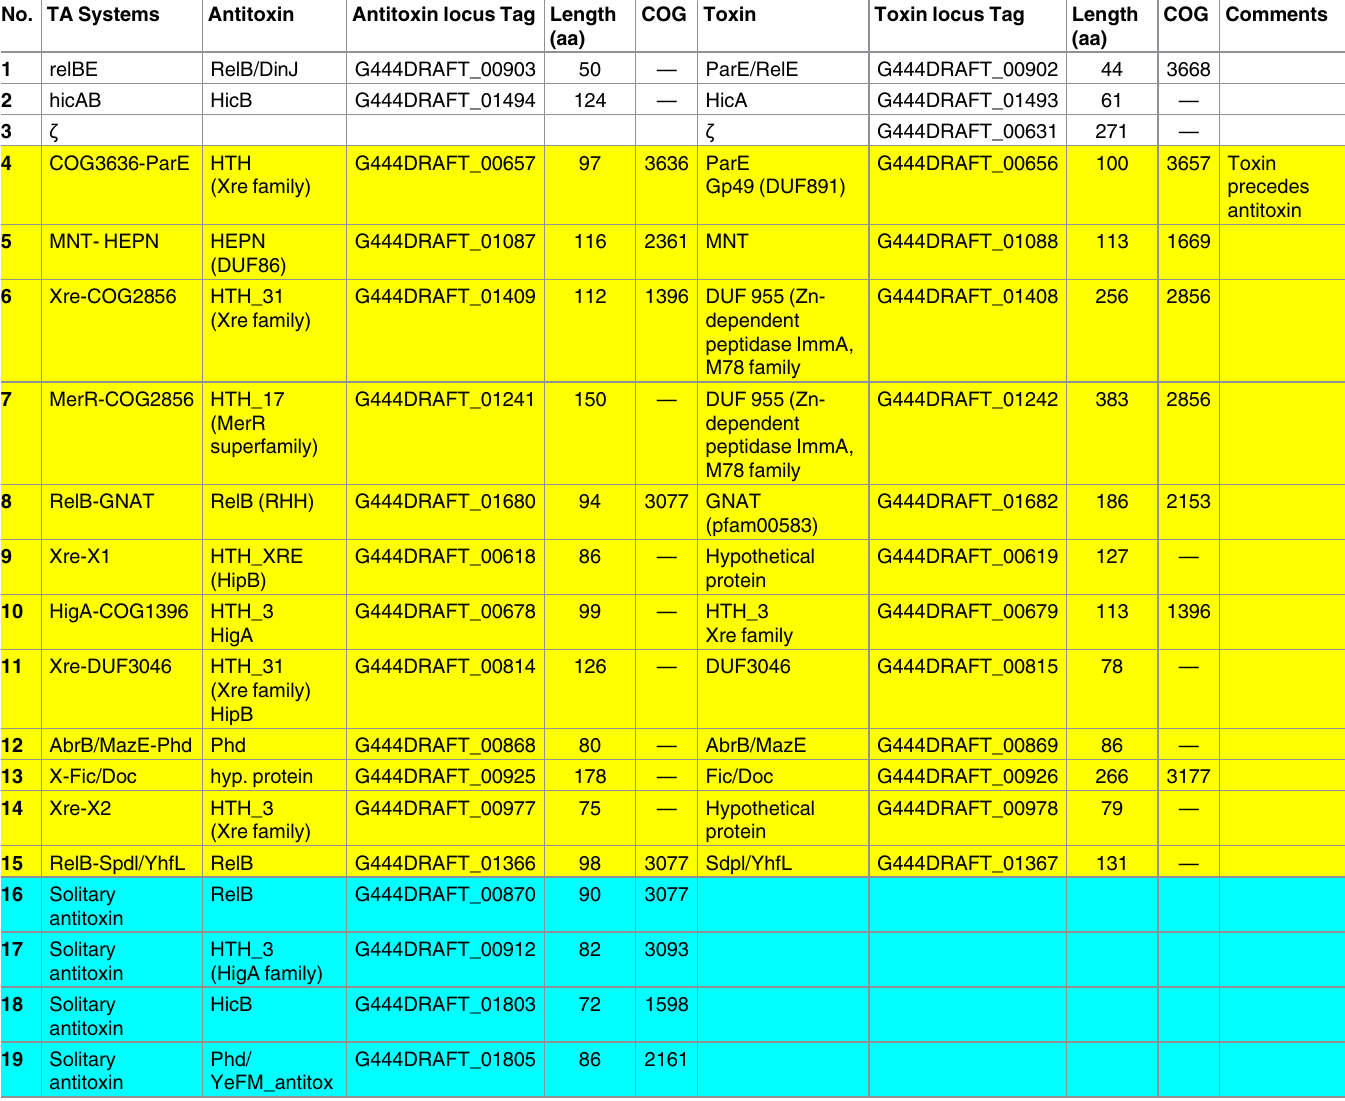
Table 2. Toxin-antitoxin systemsof Actinotignum schaalii